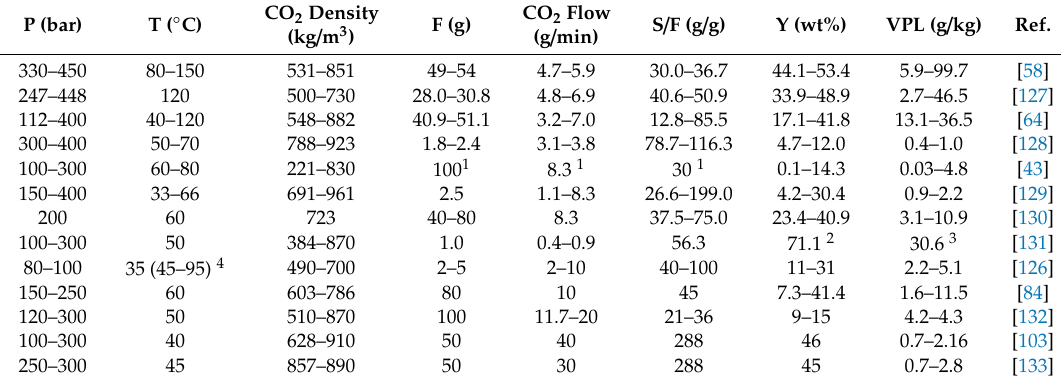
1 Normalized data are provided only; 2 achieved with the use of co-solvent (i.e., methanol); 3 average value; 4 rectification column temperatures in